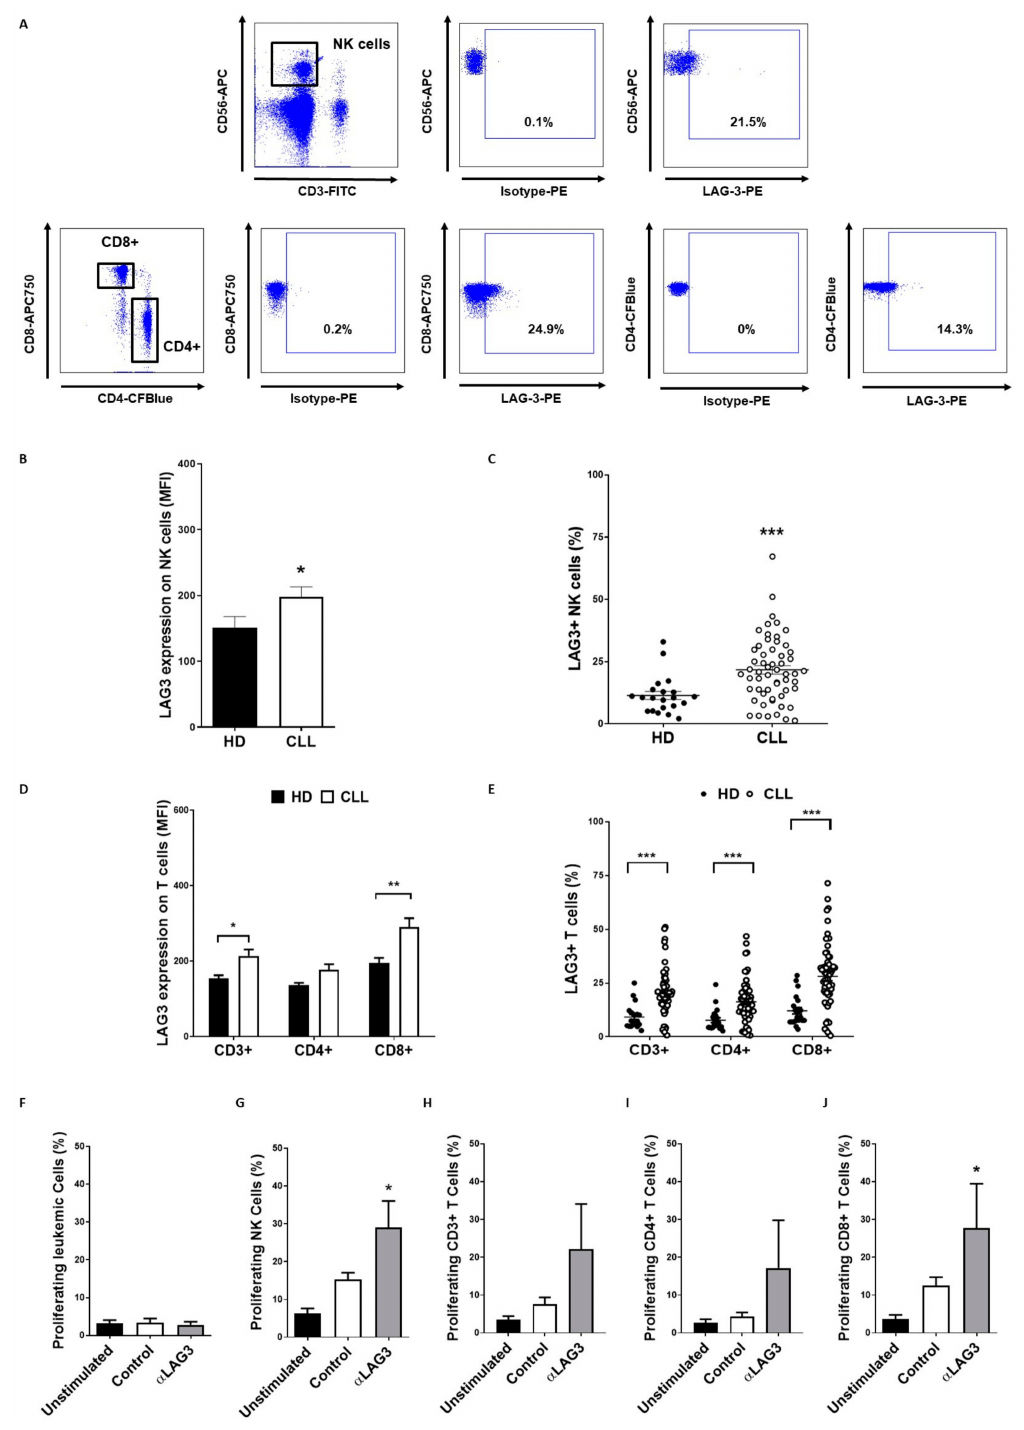
Figure 4. LAG-3 expression is increased on NK and T cells and induces immunosuppression. ( A ) Representative dot plots of percentage of LAG-3+ NK and CD8+ T cells in PBMCs from patients with CLL; LAG-3 surface expression was evaluated in 59 patients and 20 healthy donors in NK ( B , C ) and T cells ( D , E ) by flow cytometry. The graphs represent MFI ± SEM and percentage of LAG-3+ cells; The effect of LAG-3 blockade with relatlimab or isotype control (Control; 10 µ g/mL) on the proliferation of leukemic cells ( F ), NK cells ( G ) or T cells ( H – J ) stimulated with 50 U/mL IL-2 was evaluated by CFSE staining and flow cytometry ( n = 6). * p < 0.05, ** p < 0.01 and *** p <